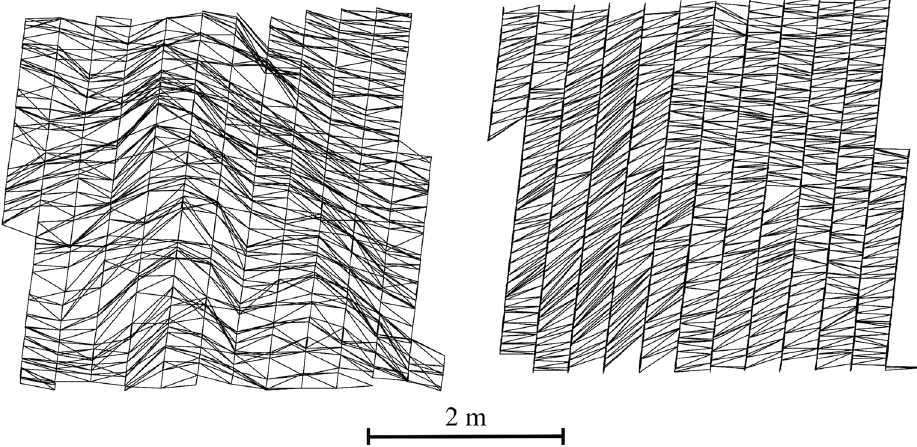
Fig. 8 A part of highwall at Coc Sau modeled by two algorithms: CC mesh (left) and BF mesh (right)